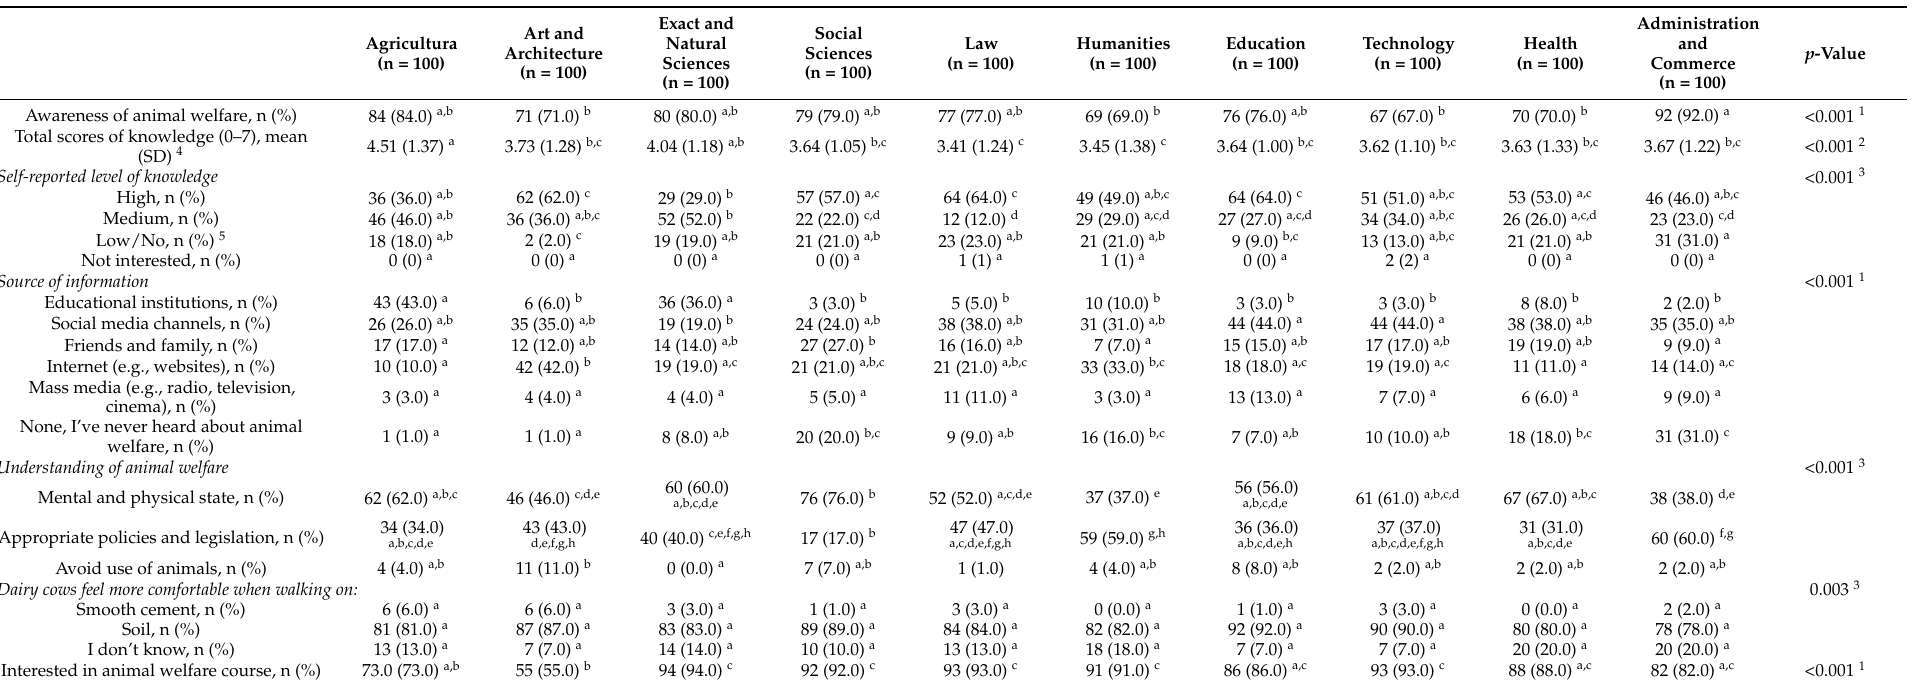
Table 3. Awareness and knowledge of animal welfare of Chilean university students from different faculties.